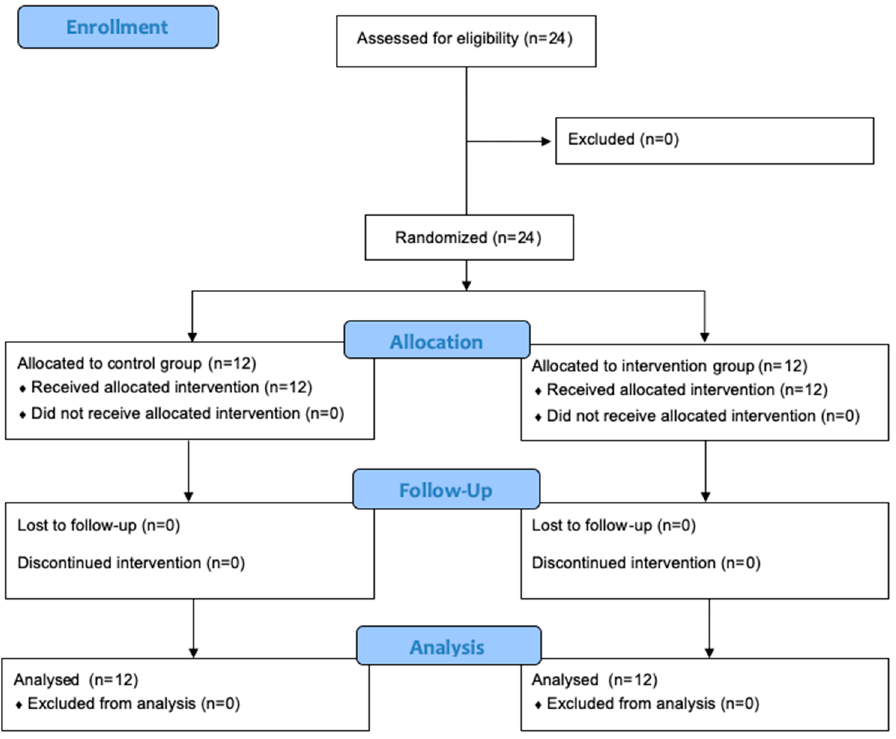
Figure 1. CONSORT flow diagram of study.